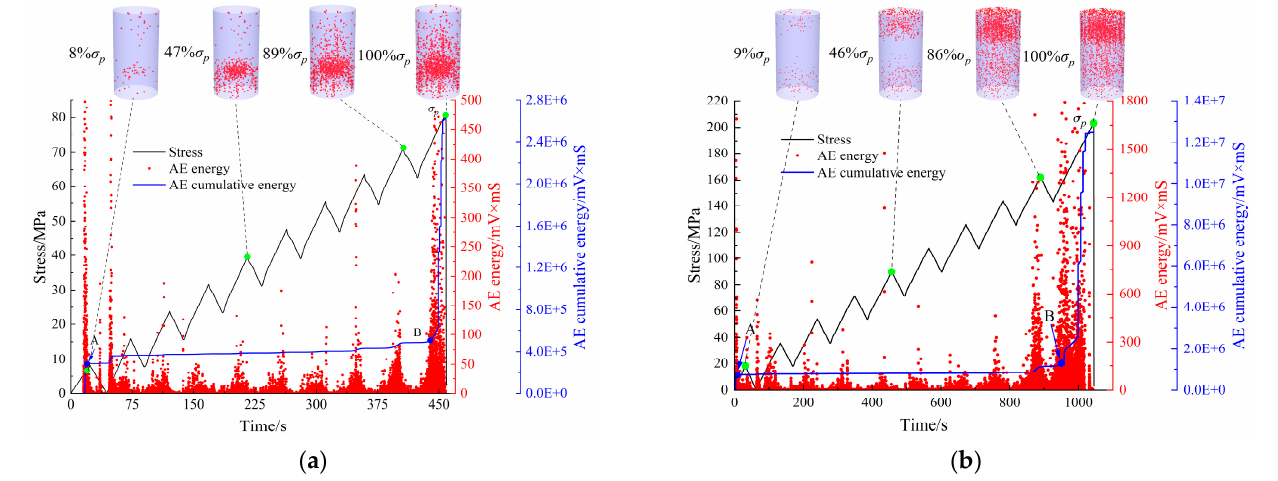
Figure 10. The AE energy and location evolution under CLLCL. ( a ) Sandstone; ( b ) granite.